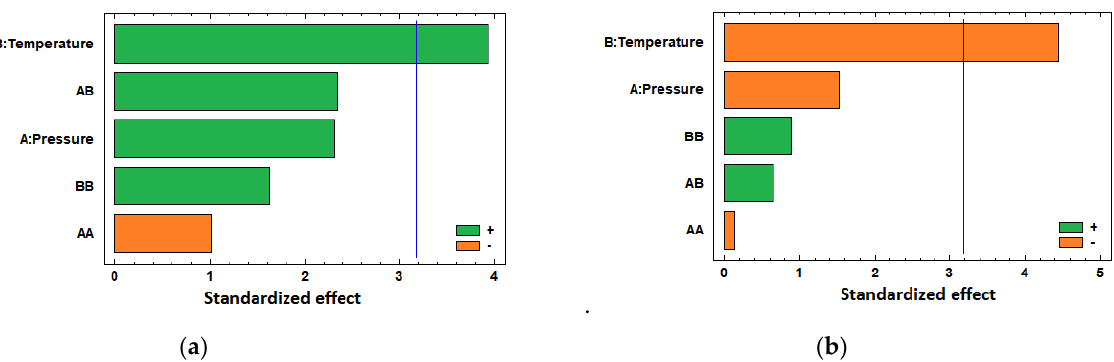
Figure 4. Ketoprofen impregnation loading by SSI into PLA filaments: ( a ) total drug loading: percentage of impregnated ketoprofen respect to the amount of PLA, and ( b ) percentage of superficial drug respect to the total drug loaded.